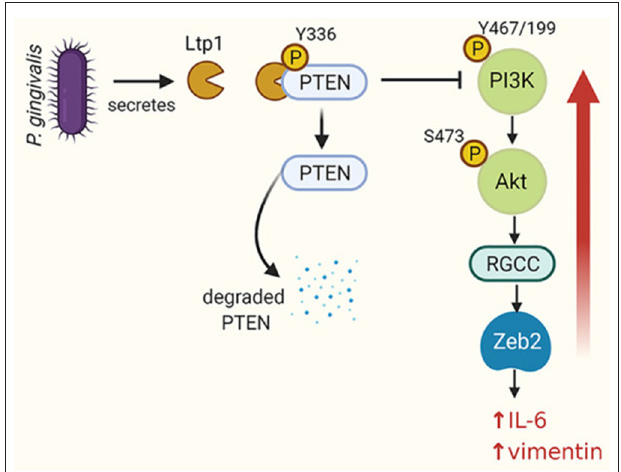
FIGURE 2 | Schematic of the impact of Ltp1 secreted within epithelial cells by P . gingivalis . Ltp1 dephosphorylates PTEN leading to proteasomal degradation. A reduction of PTEN levels relieves suppression of PI3K/Akt which upregulates RGCC and Zeb2. An increase in Zeb2 activity results in upregulation of IL-6 and vimentin. From Liu et al. [